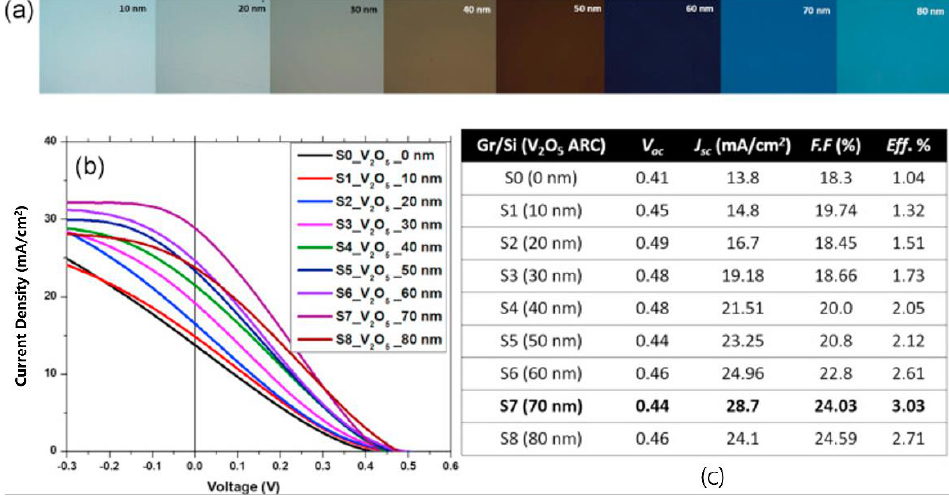
Figure 8. ( a ) Variation in the colors, ( b ) I-V characterization, and ( c ) electrical parameters of Gr/Si solar cells with different layer thicknesses (10–80 nm) of V 2 O 5 . Reprinted with permission [83]; 2018, Elsevier.